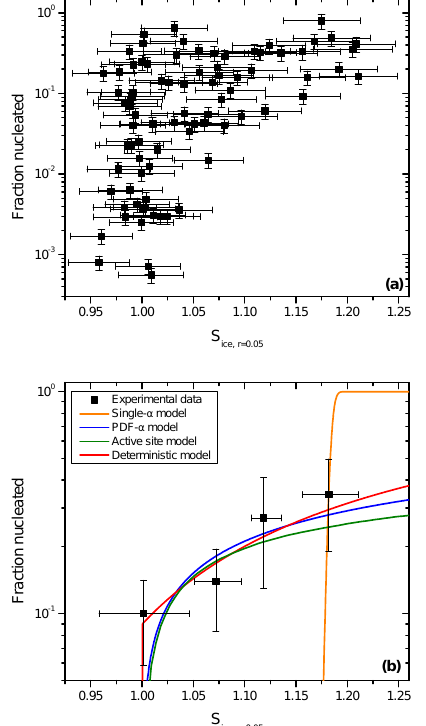
Fig. 4. Fraction of particles nucleated as a function of S ice , r = 0 . 05 for kaolinite. Panel (a) shows nucleated fraction for the individual experimental results. The y-error was calculated from the uncer- tainty in the value of ¯ D g . The x-error represents the uncertainty in S ice , r = 0 . 05 . Panel (b) shows the average nucleated fraction calcu- lated for four size bins. The range of the data points in each bin is given as the horizontal error and data points represent the average of the S ice , r = 0 . 05 values within each bin. The y-error bar in panel (b) represents the 95% confidence interval of the average nucleated fraction. Fits are shown for the single- α , PDF- α , active site, and deterministic models.